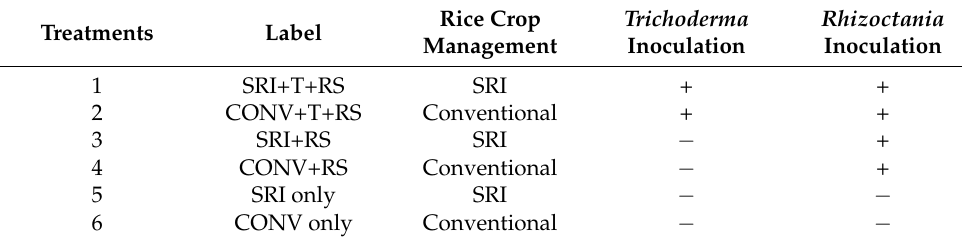
Table 1. Experimental design.